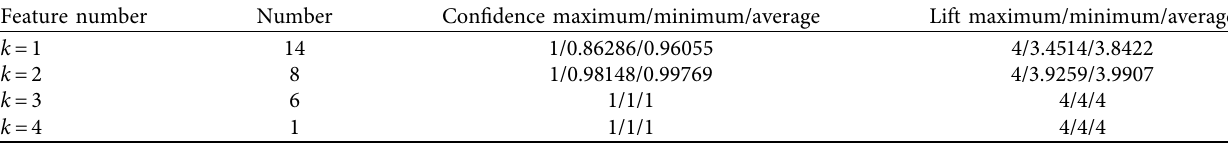
Table 9: Fault diagnosis rule extraction results based on the equal-width discretization coding method.